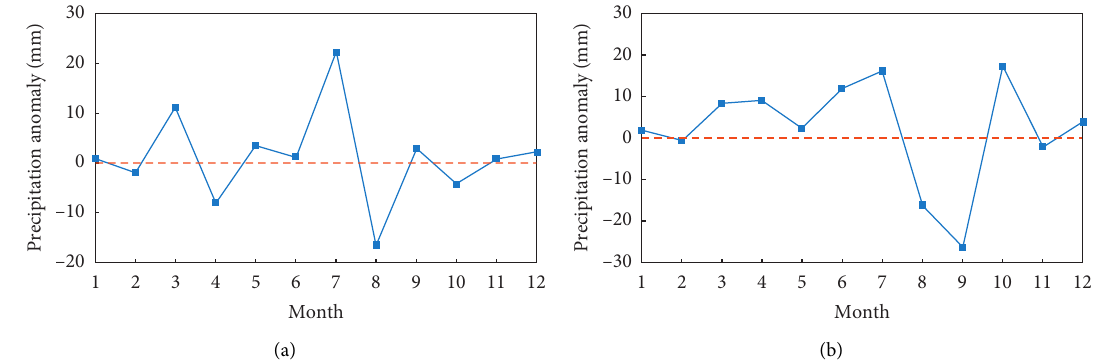
Figure 6: Monthly precipitation anomalies projected by RegCM4 (relative to 1986–2005) under RCP4.5 during (a) 2046–2065 and (b)